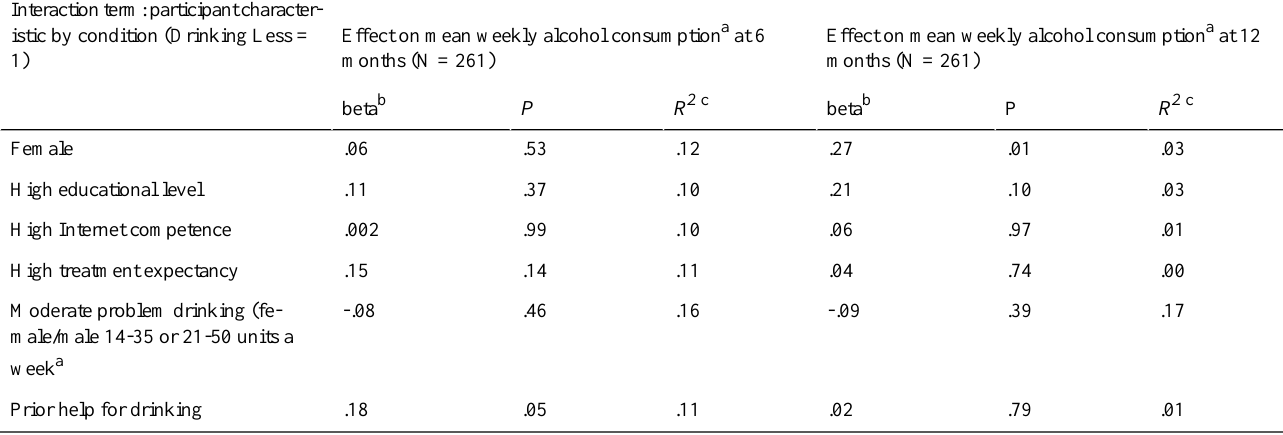
Table 3. Predictor-by-treatment interaction regressed individually using regression imputation (RI) at 6- and 12-month follow-up 261)Effect on mean weekly alcohol consumption a at 6 months (N =